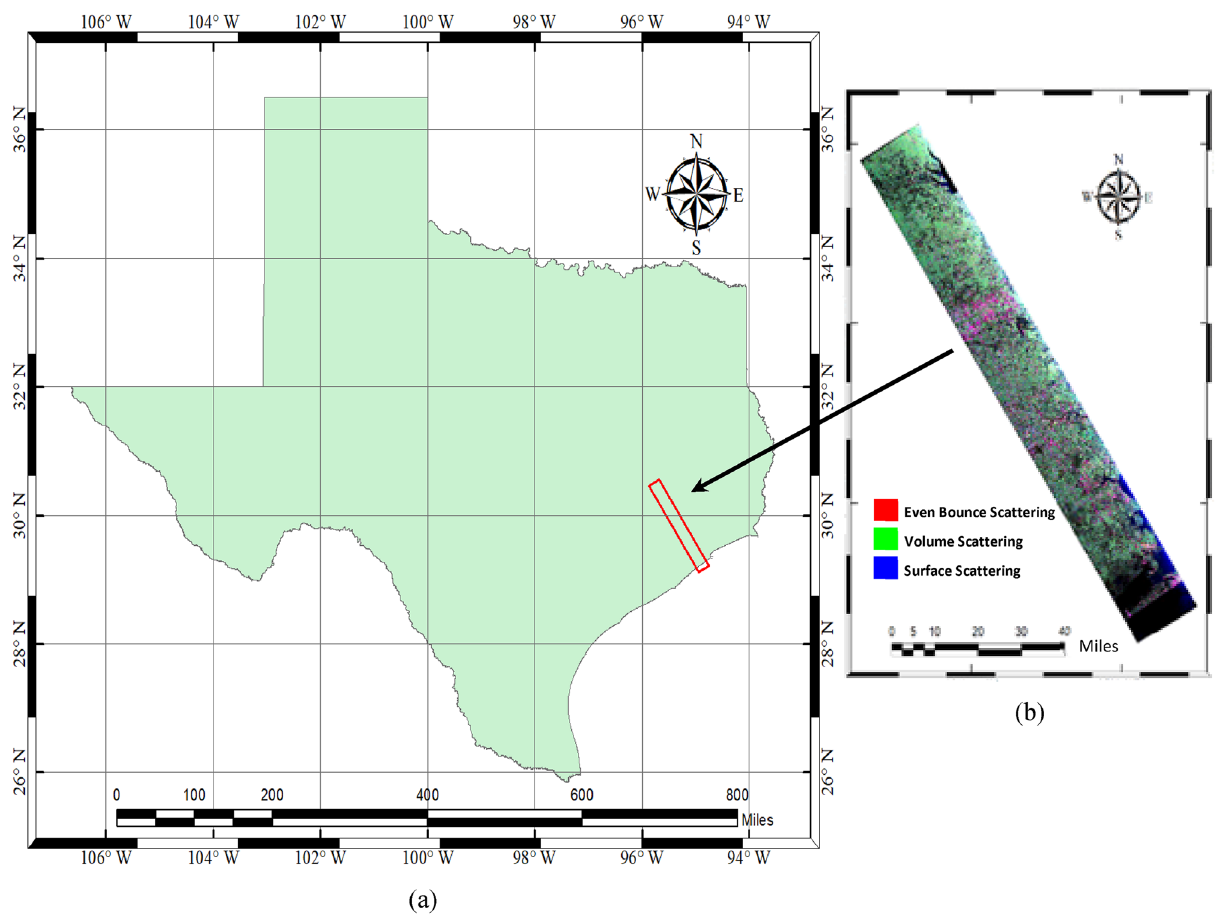
Figure 4. Represents the location of the study area compiled using ArcGIS v10.6 (URL: https:// deskt op. arcgis. com/ en/ arcmap/) ( a ) the boundary of Texas state (obtained from URL: https:// gis- txdot. opend ata. arcgis. com/) ( b ) the G4U decomposition-based false color composite image of UAVSAR data for part of Houston city, Texas (USA) generated using an open source remote sensing tool PolSARPro v6.0 (open access at URL: https:// step. esa. int/ main/ downl oad/ polsa rpro- v6-0- bioma ss- editi on- toolb ox- downl oad/).